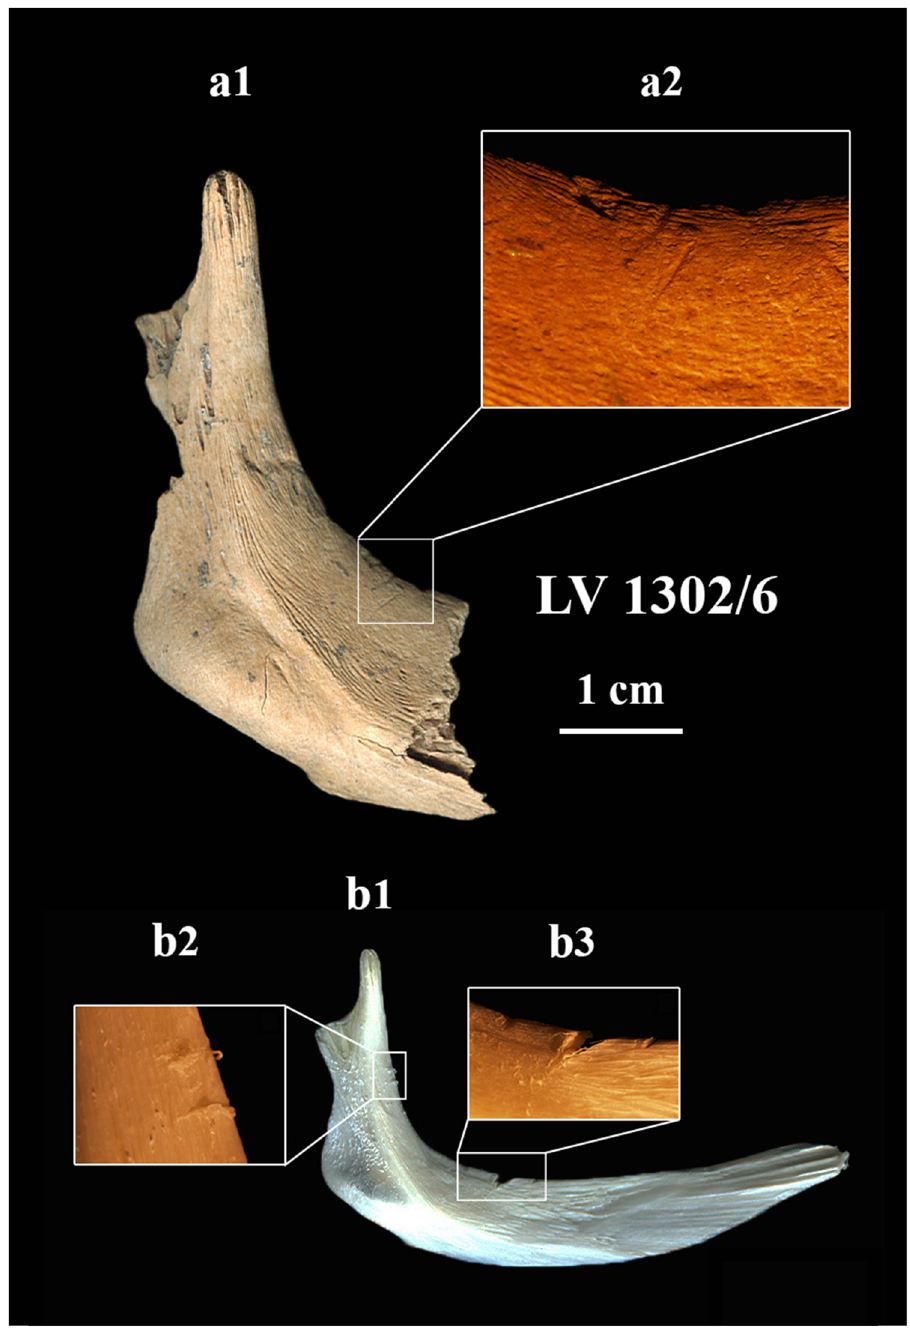
Figure 15: LV 1302/6: ( a1 ) fragment of a cat fi sh right cleithrum ( found under the fl oor of building 26, transitional phase ) , with several short oblique cut marks on the lateral side, 10 × magni fi cation ( a2 ) ; ( b1 ) comparison with a recent cat fi sh right cleithrum, with cut marks on the lateral side resulting from experimental decapitation with unretouched fl akes, ( b2 ) 30 × magni fi cation, and ( b3 ) 15 × magni fi cation. Apart from the corresponding cut marks, the fracture on the archaeological spe - cimen LV 1302/6 is most likely also a consequence of decapitation ( Figure 9.18 in Ž ivaljevi ć , 2017 )